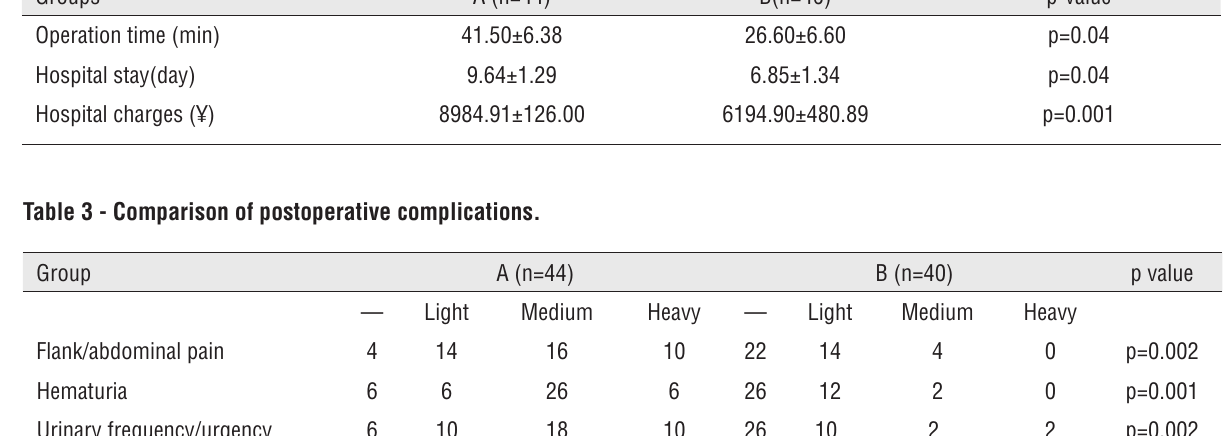
Table 2 - Operation time, hospital stay and hospital charges of patients (Mean±sD). Groups